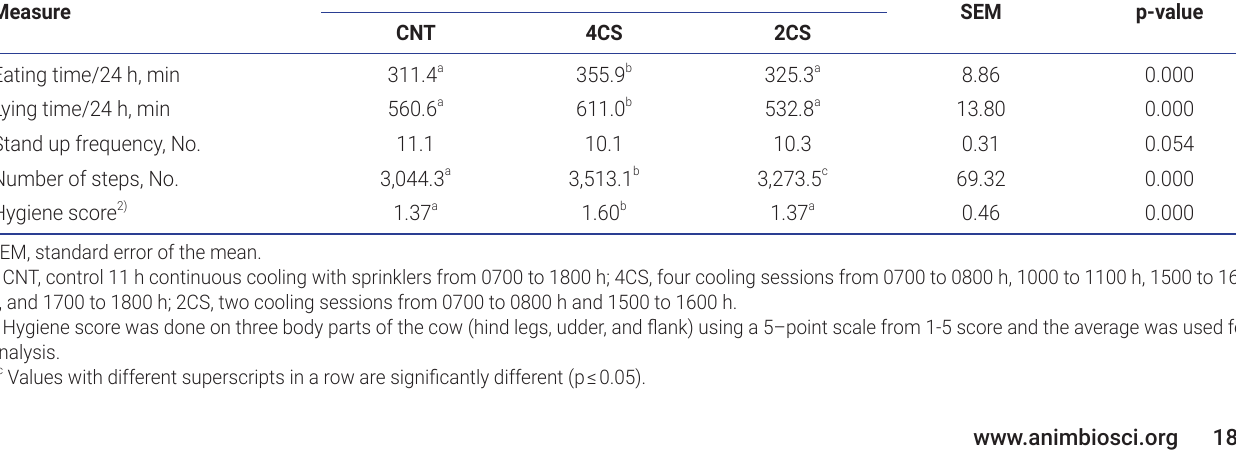
Table 4. Effect of different treatments on the behavioral responses and hygiene score of Holstein Friesian cows during summer (n = 21)